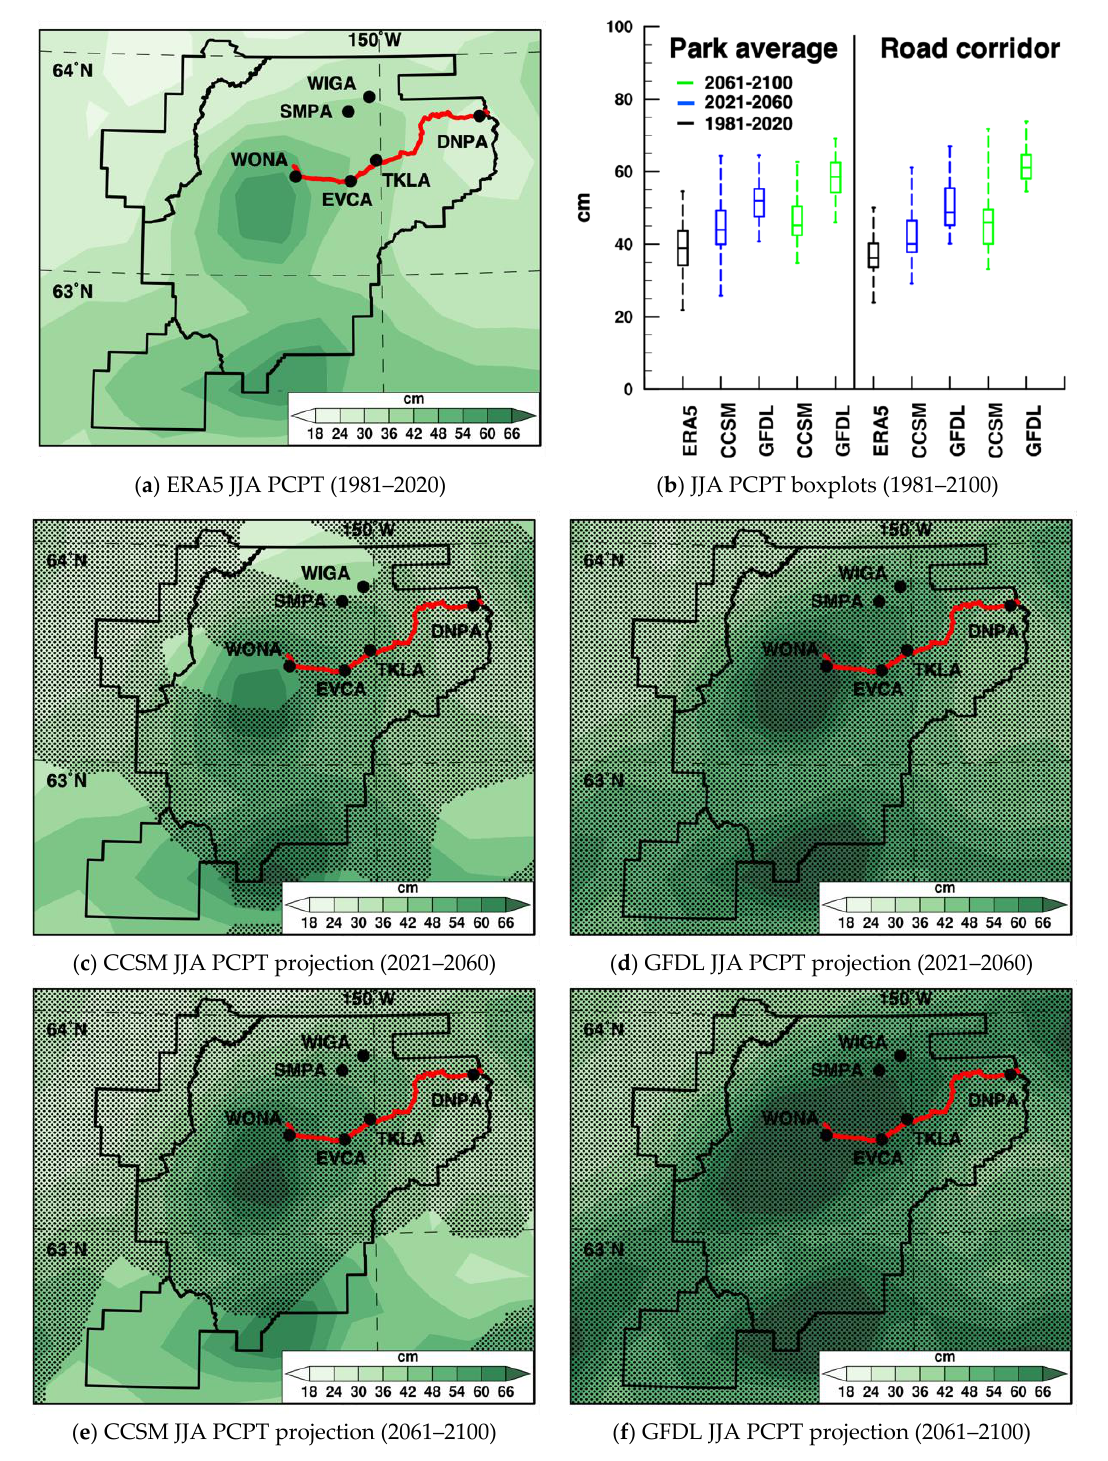
Figure 9. Denali National Park ( a ) ERA5 summer precipitation (JJA PCPT) climatology (cm), ( b ) park-average (left) and road corridor (right) boxplots of MAAT, and bias-corrected: mid-century MAAT projections from ( c ) CCSM and ( d ) GFDL and late-century MAAT projections from ( e ) CCSM and ( f ) GFDL. Projected changes at the 95% confidence level are shaded with stippling.